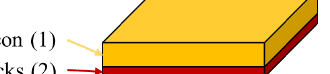
Figure 1. Concept mapping of different materials composing our Integrated Circuit (IC). The con- ductive tracks (2) are viewed through the silicon layer (1), since the remaining material is opaque to infrared